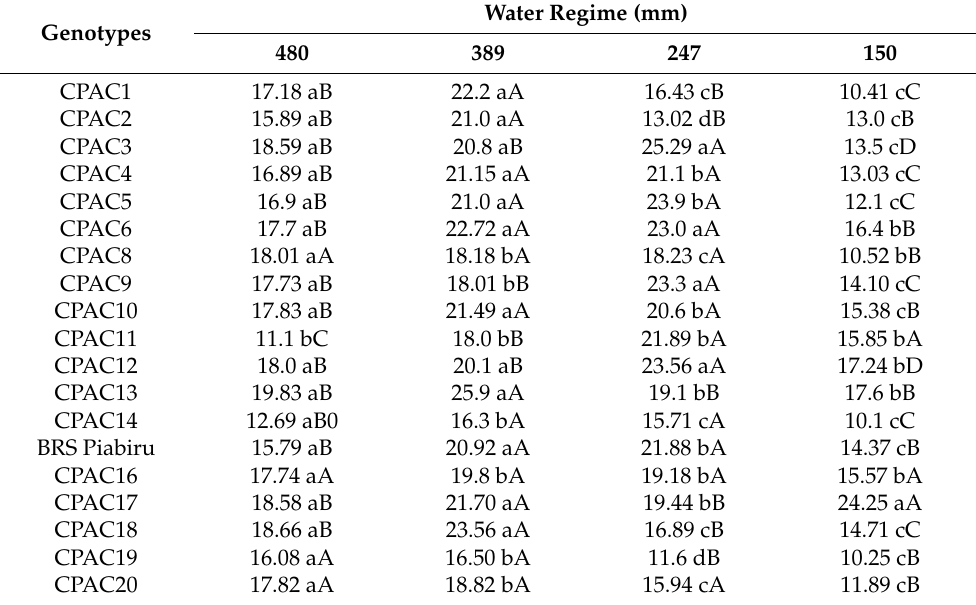
Means followed by the same lowercase letter (column) or uppercase letter (line), do not differ according to the Scott–Knott test at a 5% probability. Table 2. Productivity per unit of applied water (kg ha − 1 mm − 1 ) of 18 quinoa genotypes and BRS Piabiru under 4 water regimes.